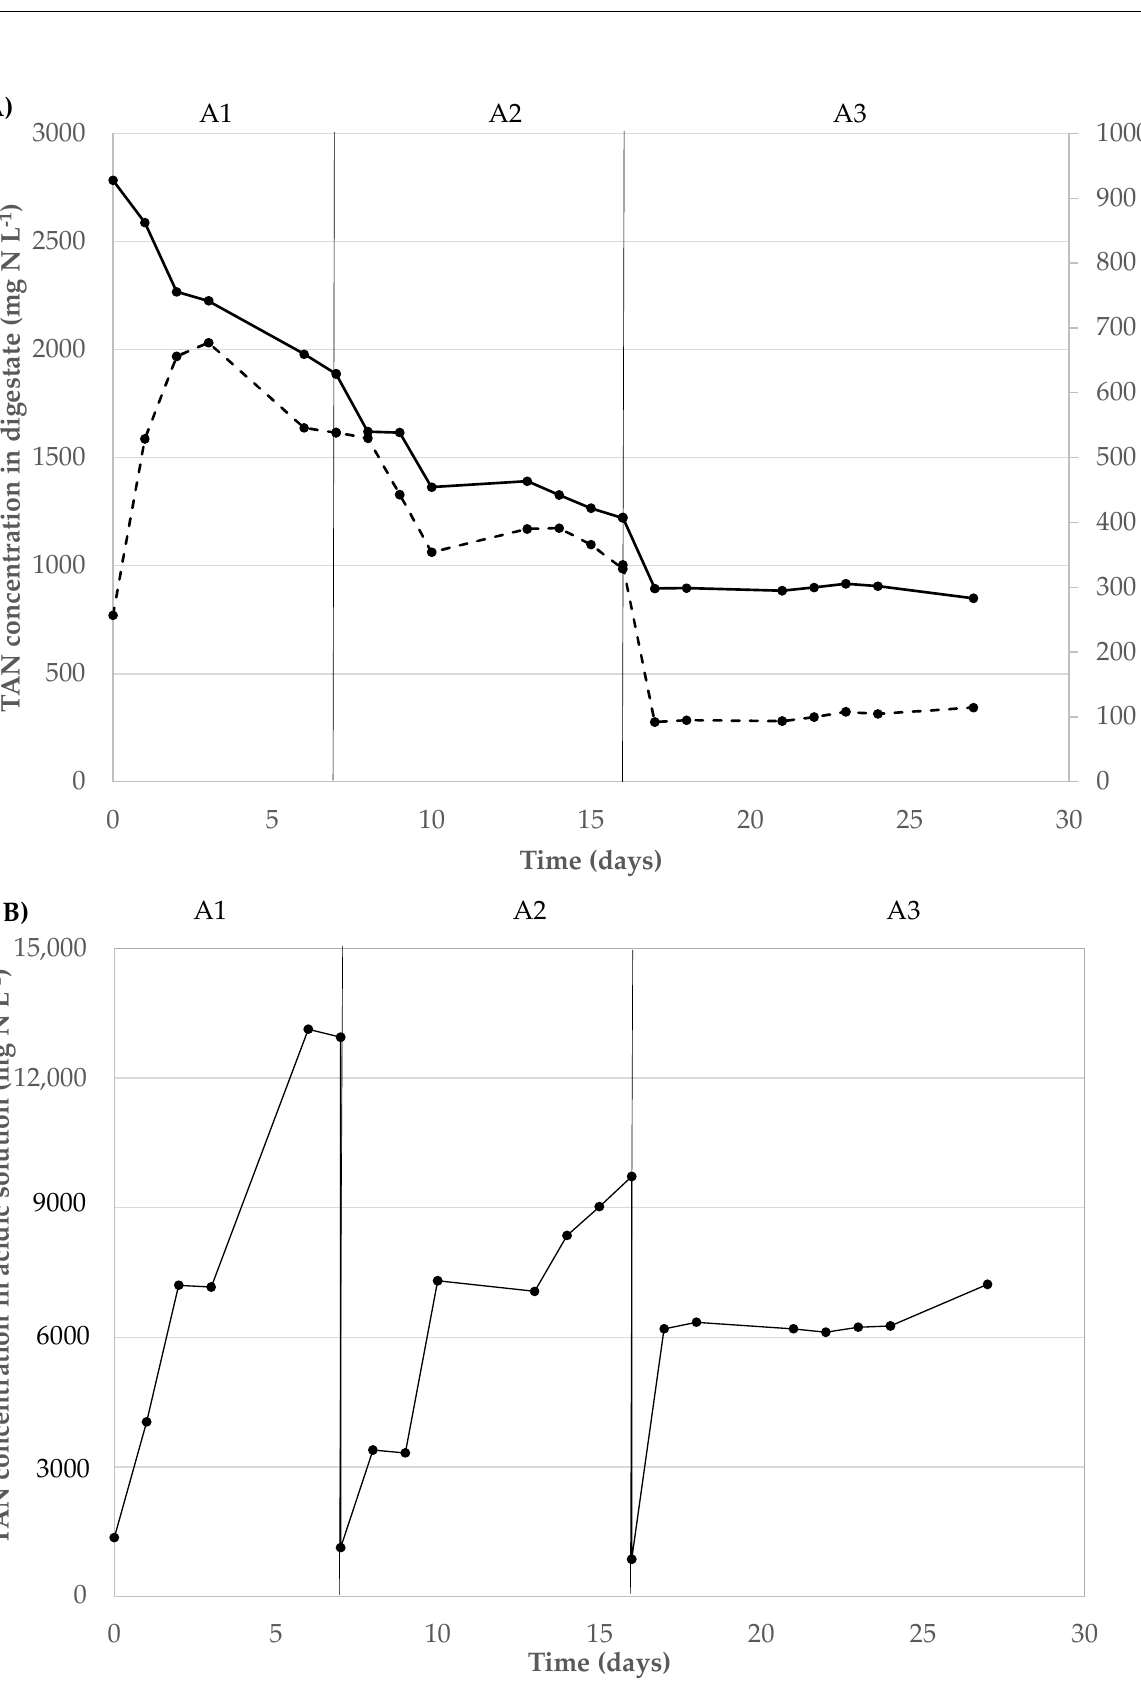
Figure 4. TAN (continuous line) and FA (dashed line) concentration in the digestate ( A ) and TAN concentration in the acidic trapping solution ( B ) in Experiment I.